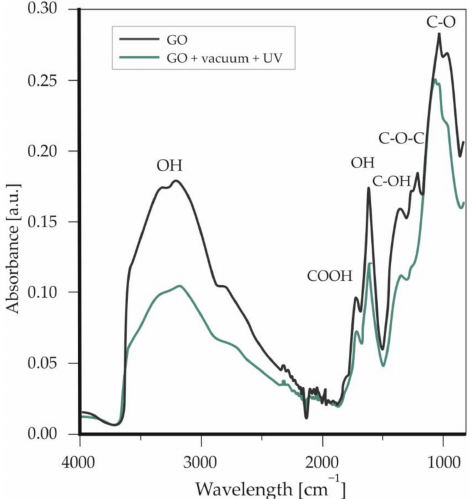
Figure 4. FTIR spectrum of GO deposited on the Petri